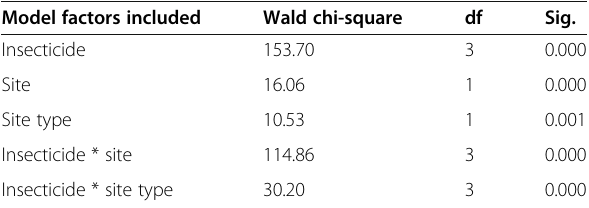
Table 2 Generalized linear model testing the effects of insecticide, site, and site type on bioassay mortality Model factors included